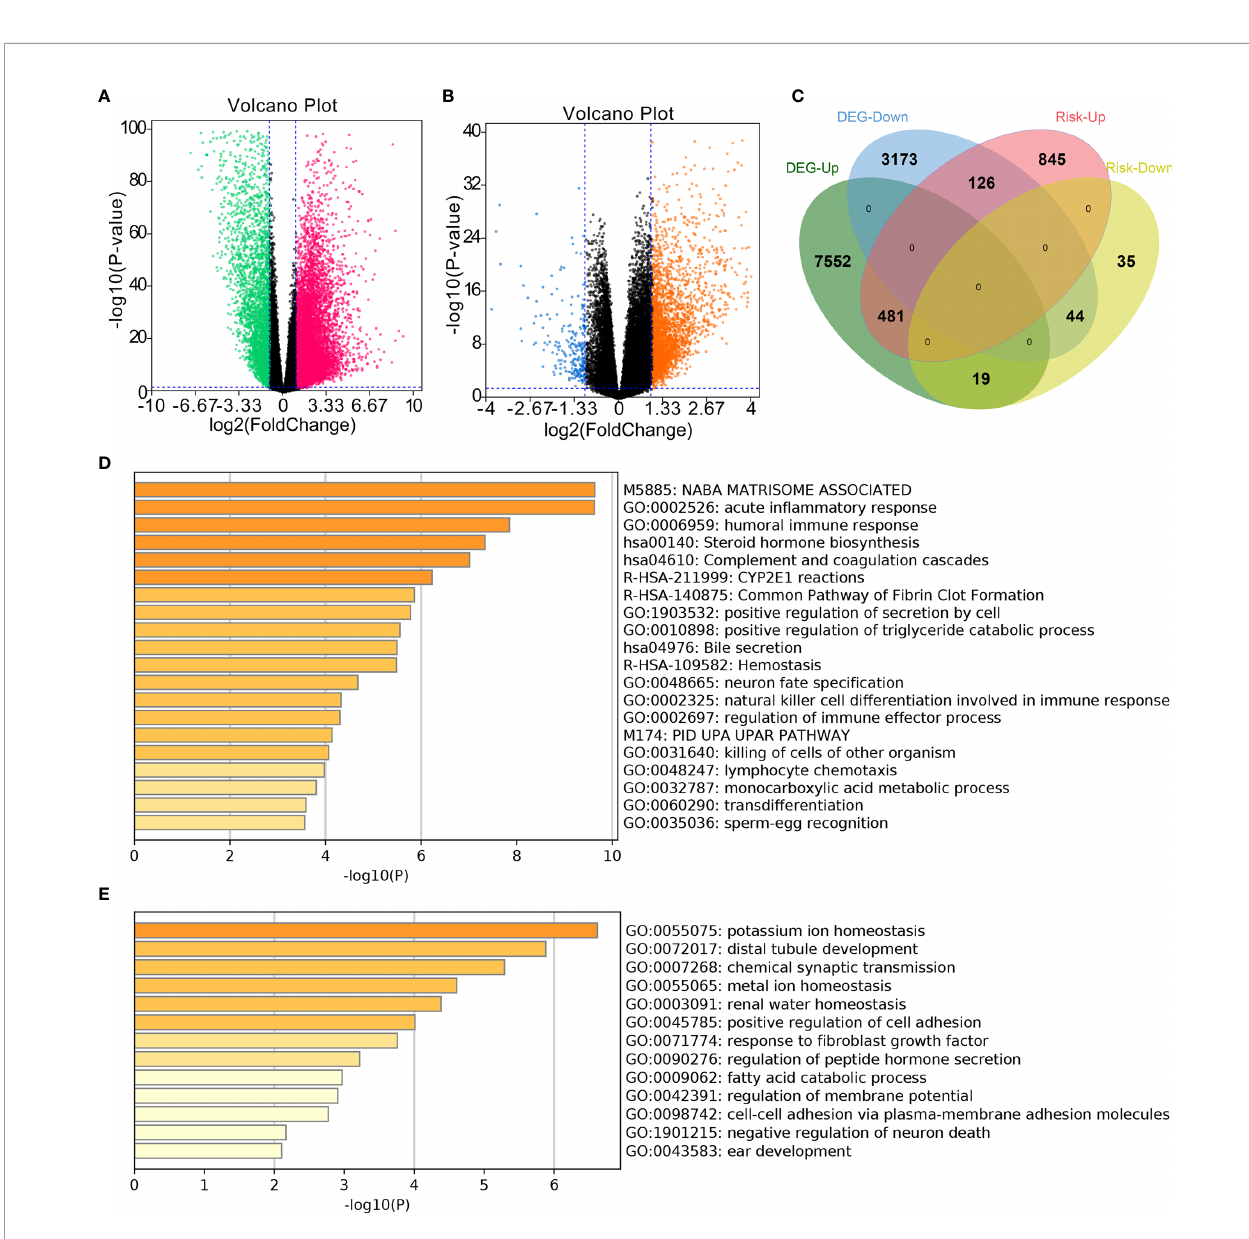
FIGURE 3 | Functional enrichment analysis of differentially expressed genes (DEGs). (A) Volcano plot of DEGs between patients with and without ccRCC. (B) Volcano plot of DEGs between patients in the high- and low-risk groups. (C) Venn diagram merging DEGs from (A, B) . (D, E) Functional enrichment analysis of signi fi cantly (D) upregulated genes associated with both tumors and increased risk of tumors, and (E) downregulated genes associated with tumors and decreased risk of